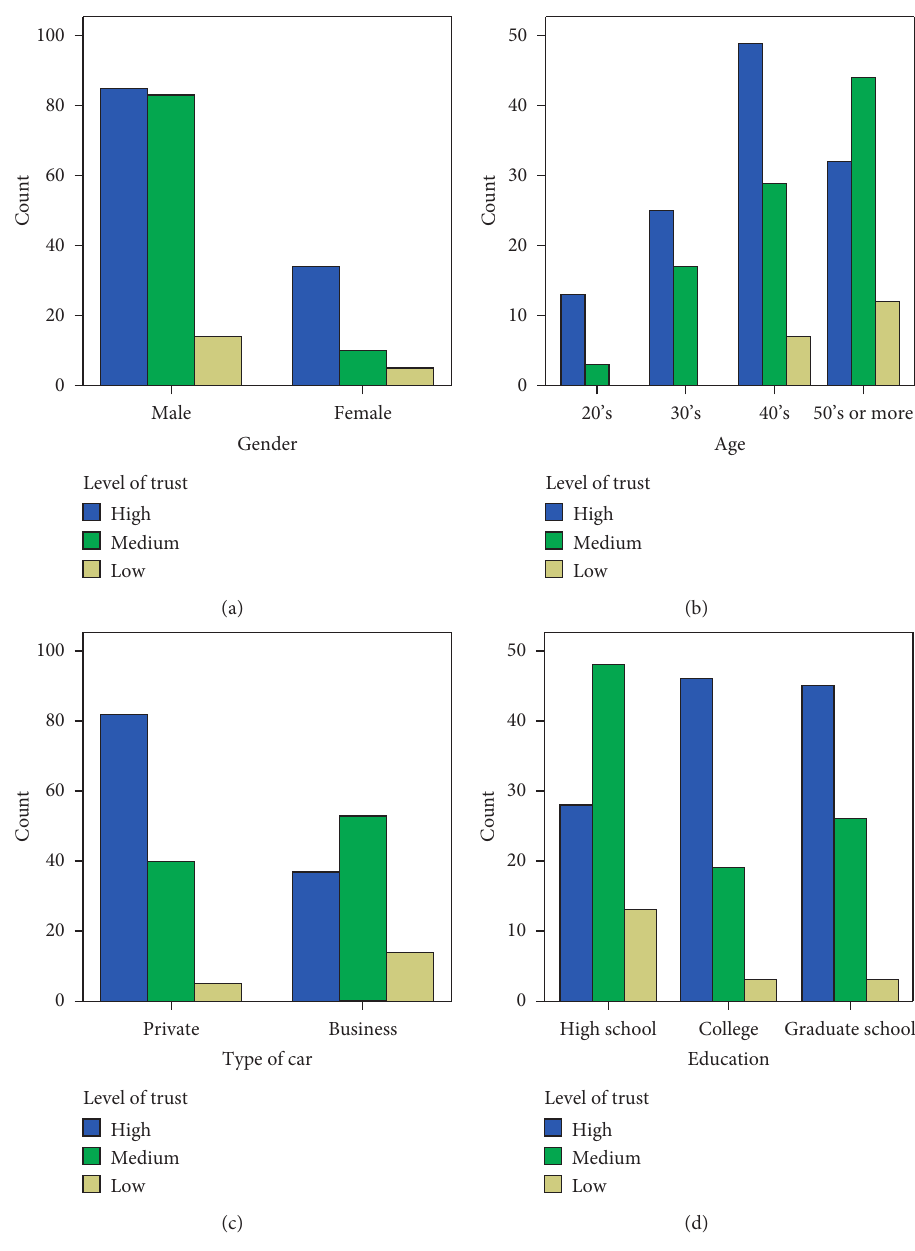
Figure 3: Level of trust of road freezing risk information by (a) gender, (b) age, (c) type of vehicle, and (d) level of